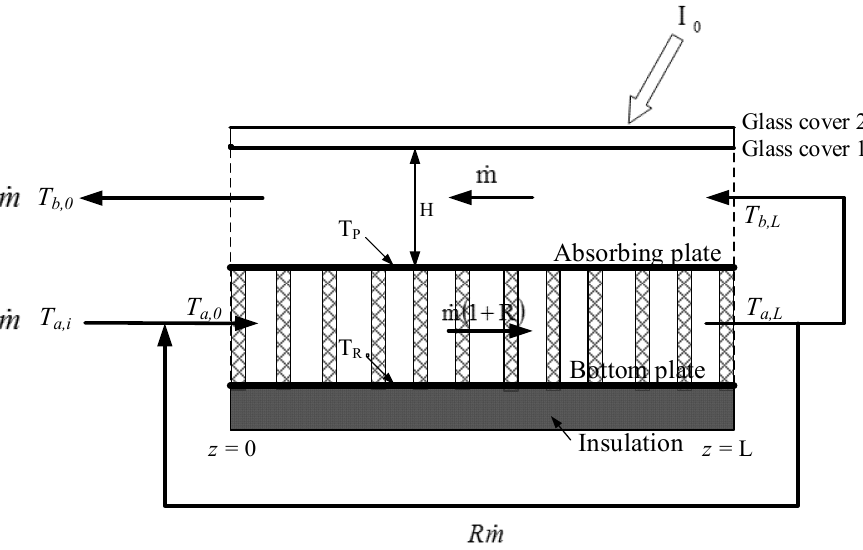
Figure 2. A double ‐ pass solar air heater with internal attached wire mesh.